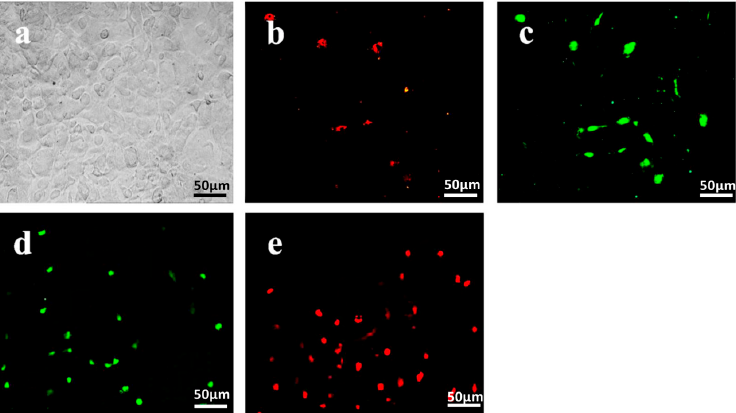
Figure 1. Identification of endothelial progenitor cells (EPCs) derived from mouse bone marrow. The mononuclear cells (MNCs) isolated from mouse bone marrow showthe characteristics of EPCs gradually. ( a ) EPCs showed cobblestone-like morphology ( × 10) after being isolated and cultured in an EGM-2MV medium for 7 days at 37 ◦ C with 5% CO 2 ; ( b ) EPCs took up DiI-ac-LDL ( × 10); ( c ) EPCs bound FITC-UEA ( × 10); ( d ) identification of EPCs by immunofluorescence for CD133 ( × 20) after culture for 21 days at 37 ◦ C with 5% CO 2 ; ( e ) identification of EPCs by immunofluorescence for FLK-1 ( × 20) after culture for 21 days at 37 ◦ C with 5% CO 2